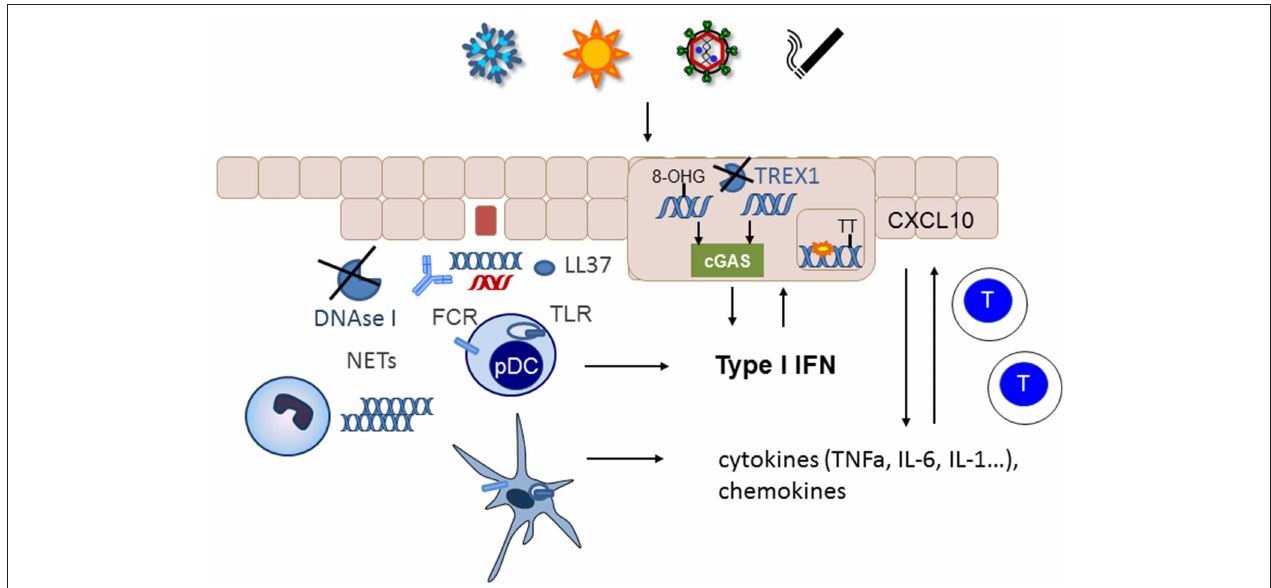
FIGURE 2 | Nucelic acid immunity in the pathogenesis of cutaneous lupus erythematosus. Cutaneous lupus lesions frequently show apoptotic keratinocytes and nucleic acids complexed with autoantibodies along the basement membrane zone (blue DNA, red RNA). In patients with defects in nucleic acids clearance such as complement defects or impaired function of DNase I these nucleic acids can be taken up by immune cells such as plasmacytoid (pDC) or myeloid dendritic cells and sensed by TLRs. Neutrophils can extrude additional DNA into the extracellular space. Phagocytosis of nucleic acids is enhanced by immuncomplexes, complexation with antimicrobial peptides such as LL37 and supported by FC-receptors. The resulting cytokine and chemokine production stimulates an adaptive immune response with infiltration of T cells into the skin. Environmental trigger factors such as UV-irradition or smoking induce DNA damage and reactive oxygen species that can cause oxidation of DNA. The 8-hydroxyguanosine (8-OHG) modification protects DNA against degradation by TREX1. The unrestricted DNA can accumulate in the cytoplasm and induce cGAS stimulation leading to type I IFN induction. In patients with deficiency in TREX1 intracellular DNA can accumulate as danger signal. Other mutations such as RNAseH2 cause ribonucleotide accumulation in DNA that predisposes to cyclobutanpyrimide formation after UV-irradiation and thereby enhance cellular